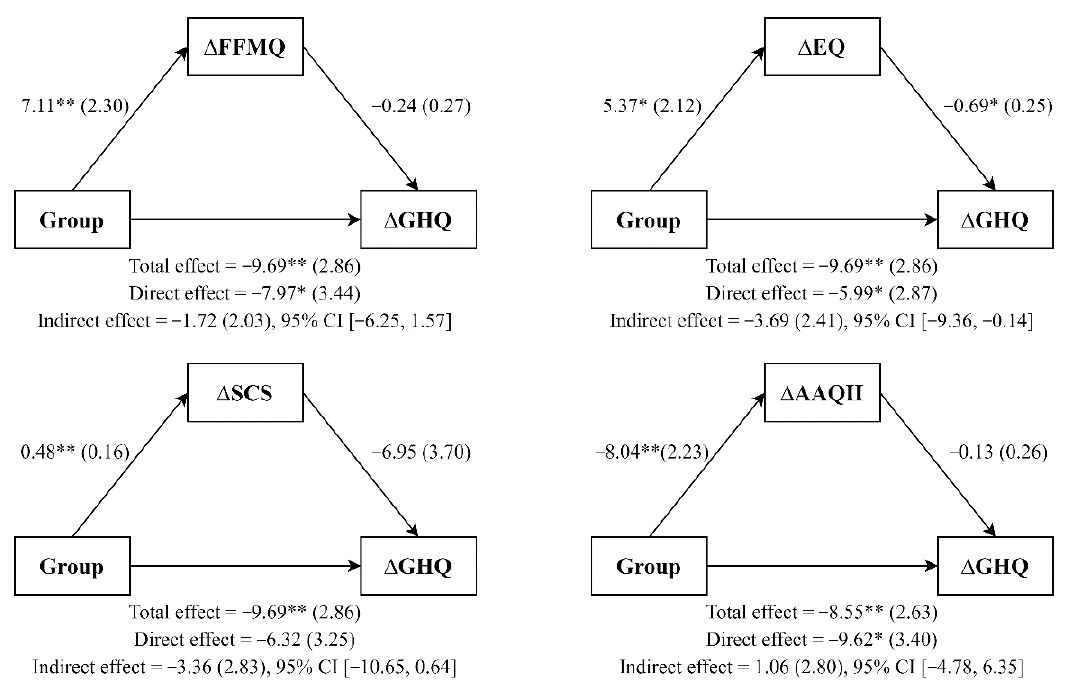
Figure 3. Simple mediation analyses. Note. All coefficients represent unstandardized regression coefficients (standard errors in parenthesis). * p < 0.05; ** p < 0.01.